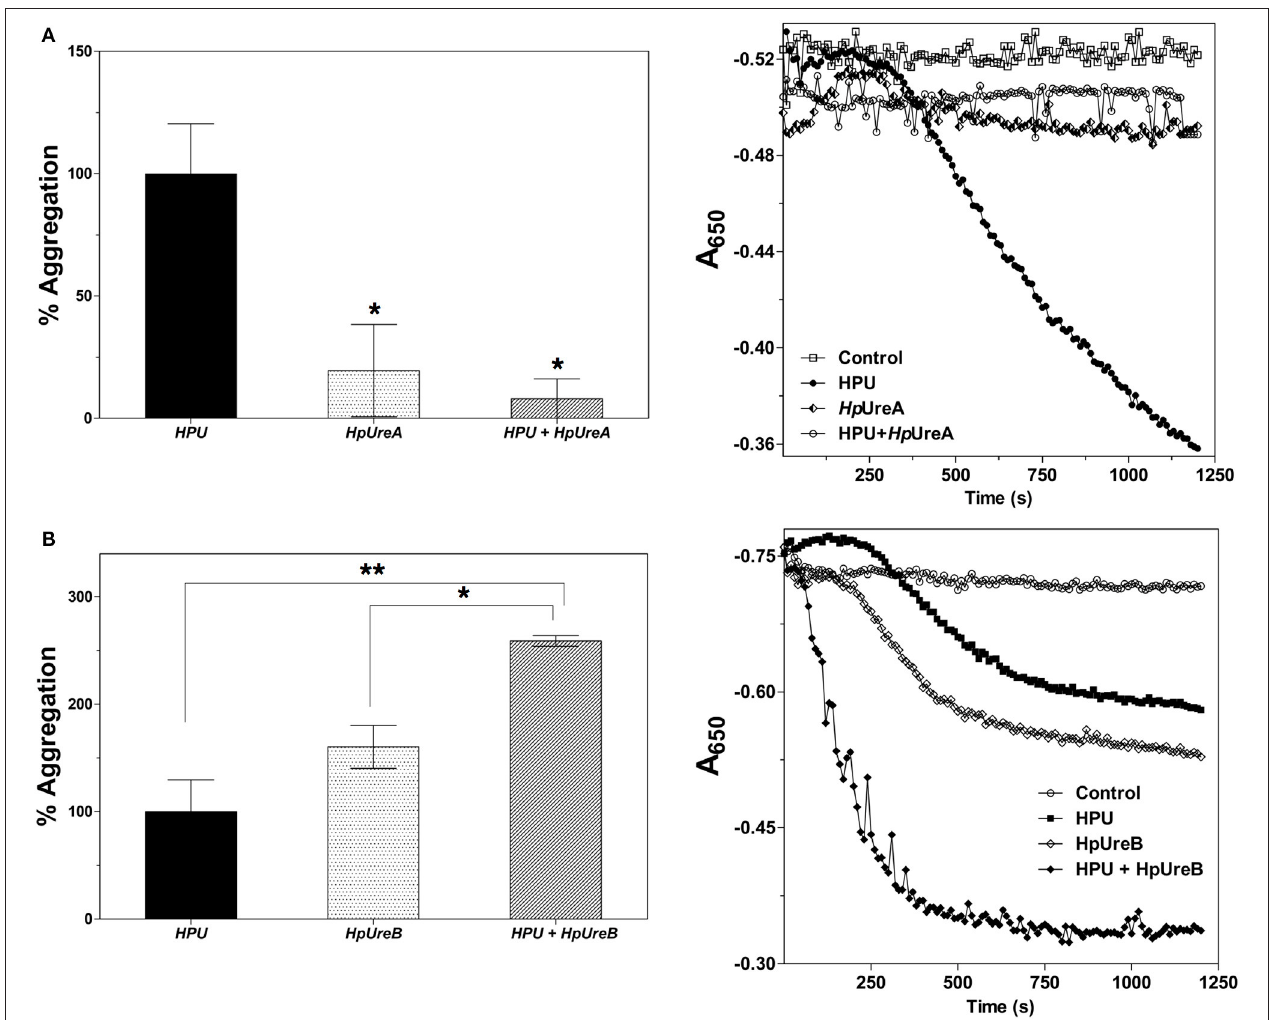
FIGURE 3 | HPU subunits interfere on HPU-induced platelet aggregation. Pretreatment of rabbit platelets with HpUreA (A) or HpUreB (B) interferes on platelet aggregation induced by 300nM HPU. Platelets were pre-incubated for 5min at 37 ◦ C without stirring with 1 µ M HpUreA or HpUreB and then challenged with 300nM HPU. Platelets’ responses are expressed as percentage of the maximum aggregation produced by HPU (left panels). Aggregation was monitored in a plate reader SpectraMax ® M3 (Molecular Devices), with readings every 11s for 20min at 650nm. Superimposed tracings of individual experiments are shown in the right panels. The aggregation responses were quantified as area under the tracings (SoftMax Pro 5.4.1). Data are expressed as means ± SEM. Statistical significance was determined by ANOVA followed by Tukey-Kramer test. Values of * p < 0.05, ** p <